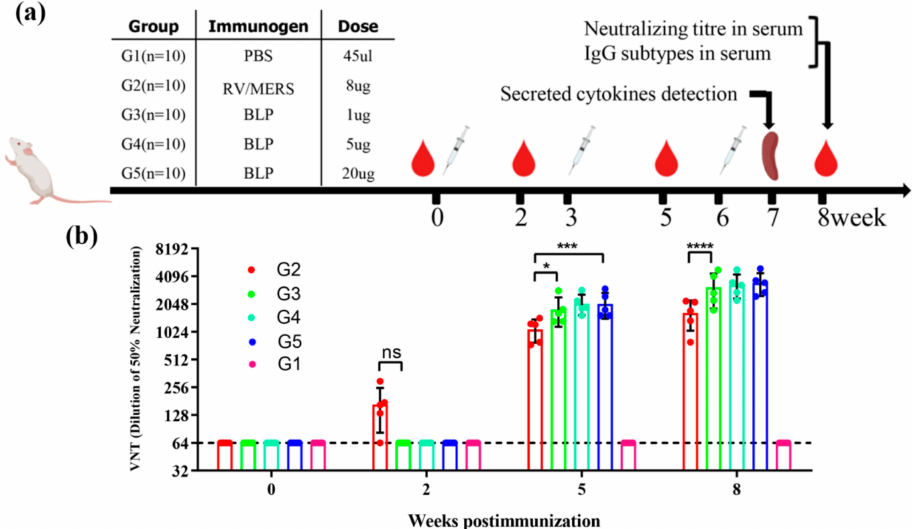
Figure 2. Schematic diagram of immunization and neutralizing antibody responses. ( a ) The vaccination schedule and characterization of immunologic responses in BALB / c mice. A total of five groups of mice were immunized and detected for virus-neutralizing antibody, IgG subtypes, and cytokines release. Group 1 (G1) was negative controls; group 2 (G2) was vaccinated with inactivated and purified rabies virus (RV) / Middle East respiratory syndrome (MERS); group 3, group 4, and group 5 (G3, G4, G5) were vaccinated with varying doses of the MERS bacterium ( Lactococcus lactis )-like particle (BLP). All groups received a second and third identical vaccination boost with a combined adjuvant at 3-week intervals after the primary immunization. ( b ) Neutralizing activity was detected by using MERS coronavirus (MERS-CoV) pseudovirus, and the data are shown as the mean ± SD from five mice in each group and were analyzed by Student’s t -test (* p < 0.05, *** p < 0.001, **** p < 0.0001, n =